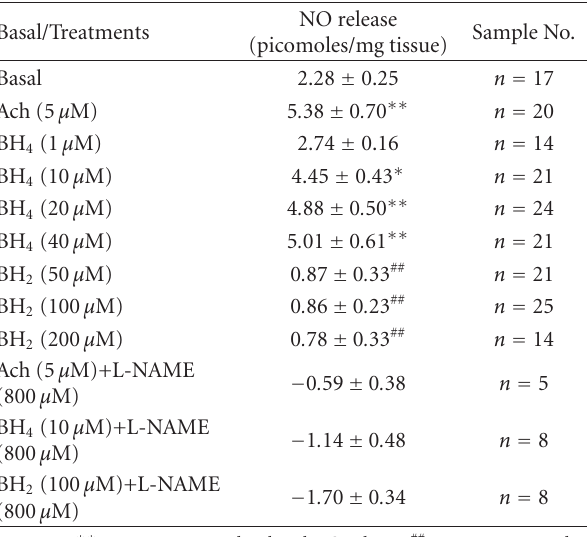
Table 1: The e ff ects of BH 4 or BH 2 on NO release from nonischemic rat aortic